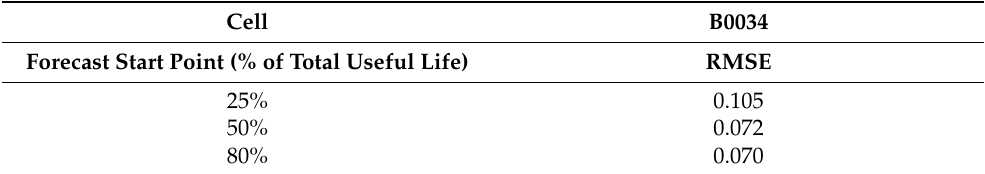
a discharge current of 4 A (C-rate of 2).